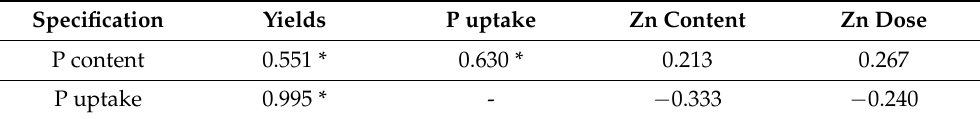
Table 5. Linear correlation coefficients between selected properties of test plant. Specification